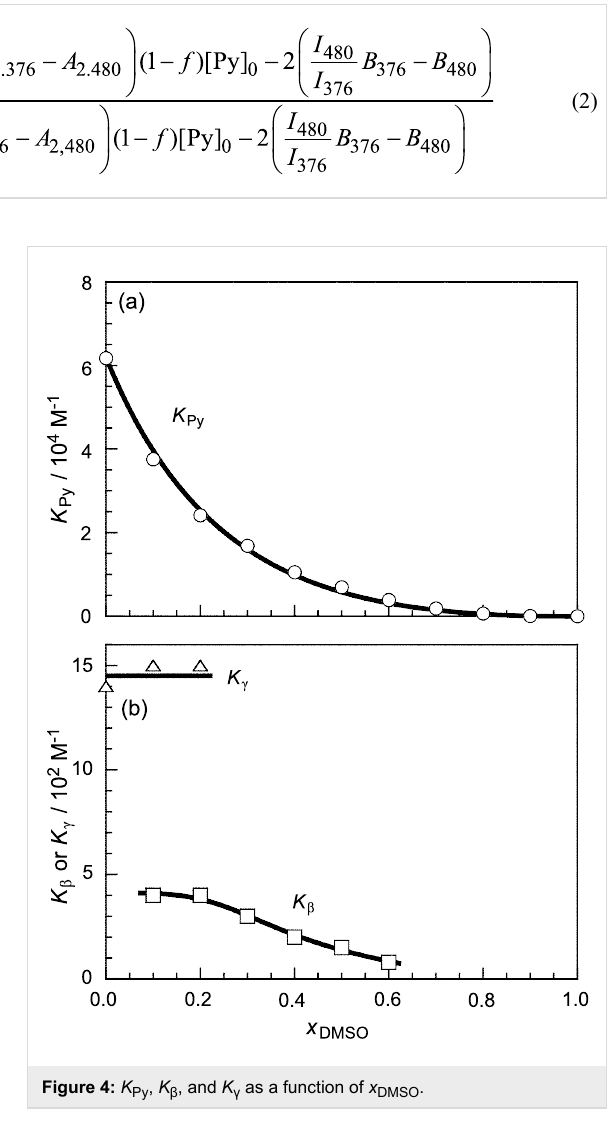
(Supporting Information File 1). It is also likely that A 2,376 = 0. When K β and A' 1,376 / A 1,376 are chosen appropriately, the